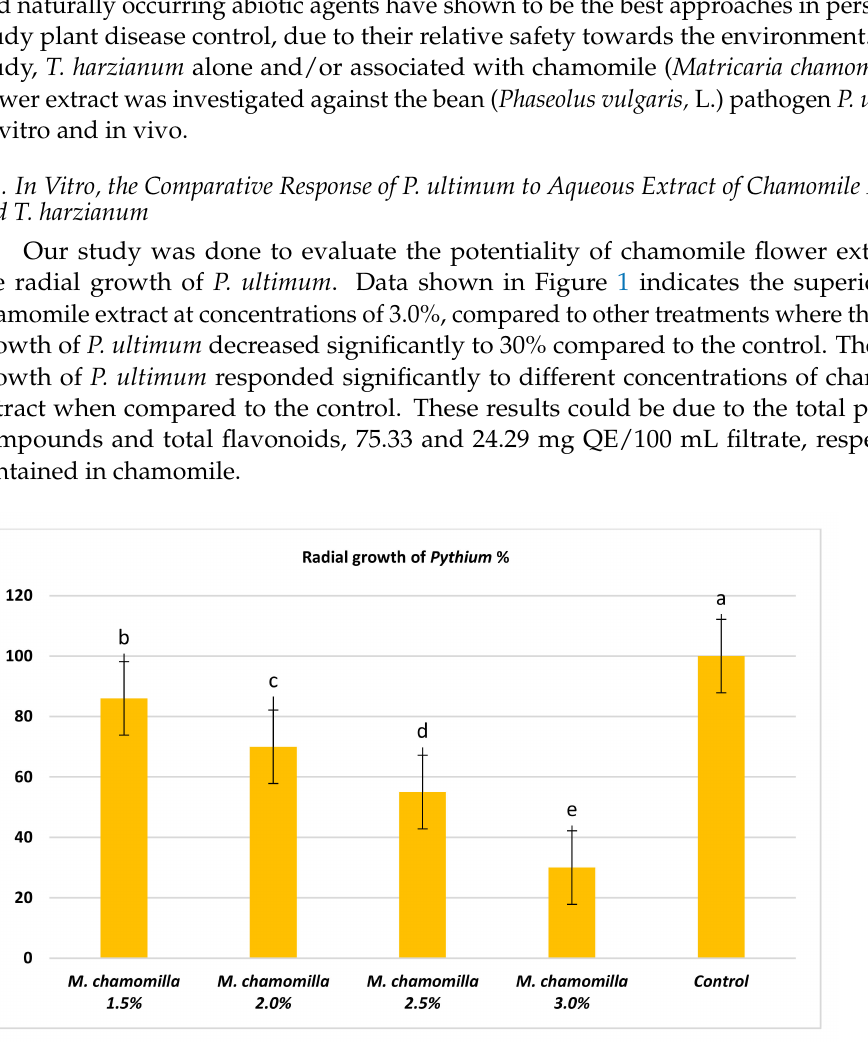
Figure 1. Radial growth (%) of P . ultimum as a responded to thresholds of chamomile flower